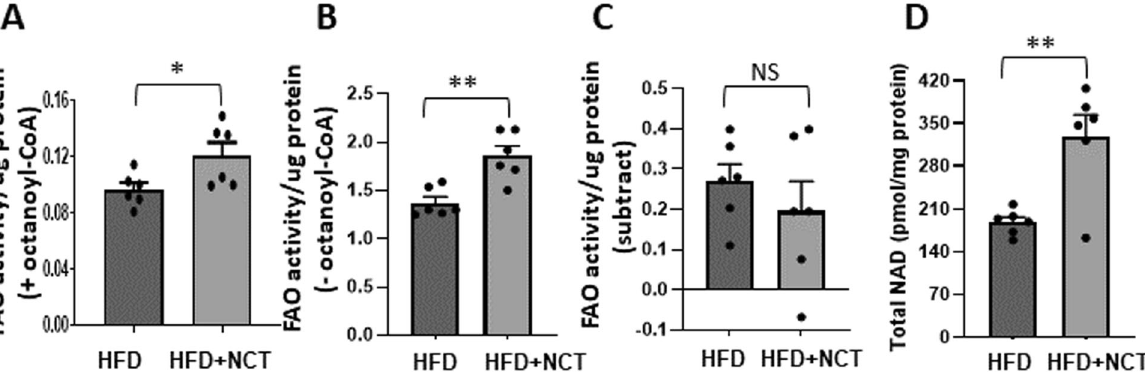
Fig. 2 NCT increased hepatic mitochondrial mass. A FAO activity in liver lysate prepared in the presence of octanoyl-CoA. B FAO activity prepared in the absence of octanoyl-CoA. C FAO activity + octanoyl CoA minus FAO activity – octanoyl CoA. D Total hepatic NAD level. Dots indicate individual mice ( N = 6). Values represent the mean ± SEM. * p < 0.05, ** p < 0.01 (HFD vs HFD + NCT). NS non-signi fi